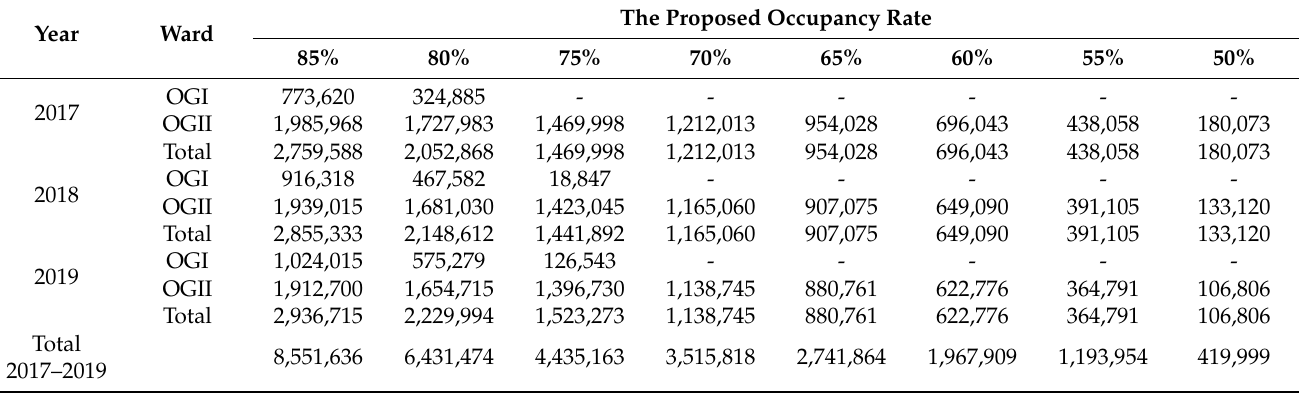
Table 4. Evolution of assumed net income in RON by ward occupancy from 2017 to 2019 for elective caesarean section births for a fee.